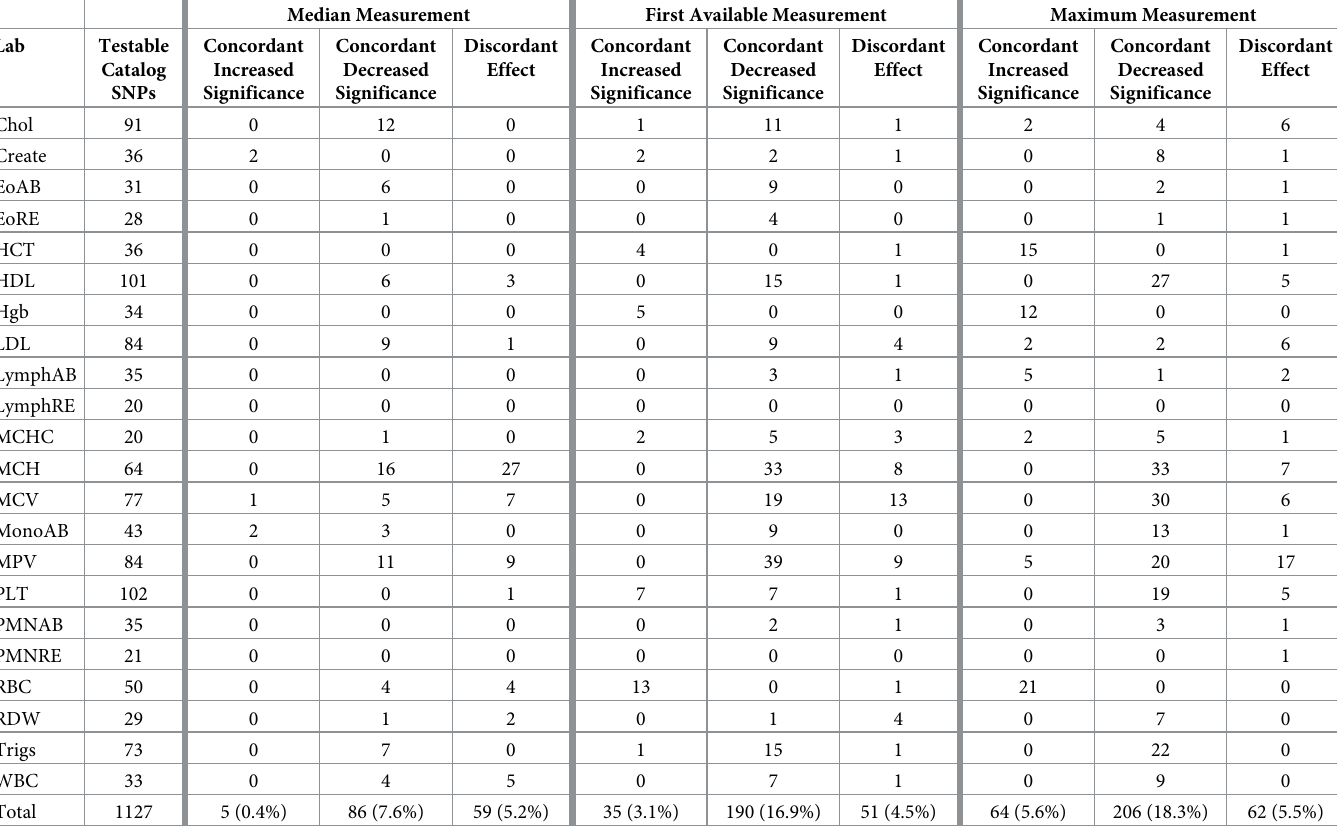
Table 3. Classification of catalog SNPs for alternate summary